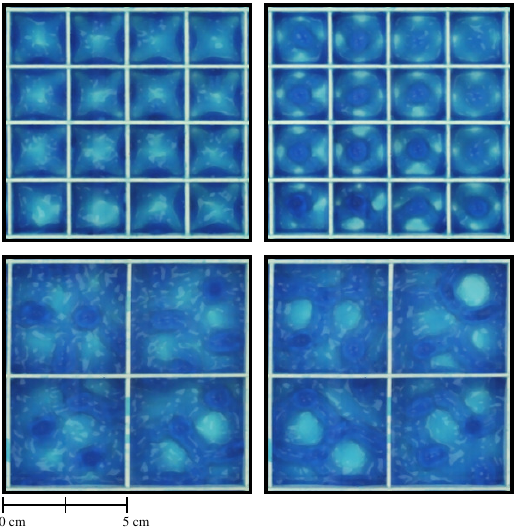
Figure 5. Top view images of a portion of the grid showing the resulting patterns at F = 18 Hz for cells of size l = 2.5 cm ( A = 1.3 mm; top images ) compared to those resulting for cells of size l = 5 cm ( A = 1.1 mm; bottom images